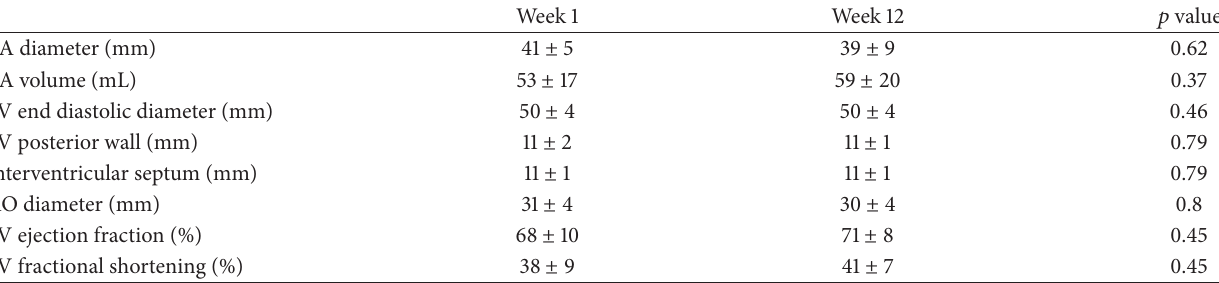
Table 3: Cardiac dimensions and LV ejection phase indices before and after weight